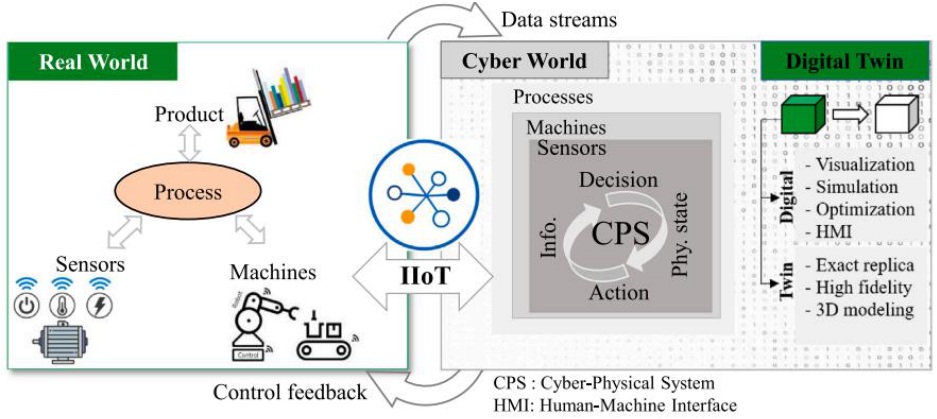
Figure 17. Functional relationships between industrial objects and processes from the real environ- ment to cyberspace based on industrial IoT, data flows and DT [114].